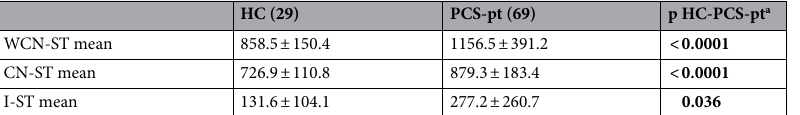
Table 5. Results by Mann Whitney analysis for comparing parameters of Stroop Task (ST) RTs, for conditions (WCN–CN) and derived RTs (I). WCN word color naming, CN color naming, I interference, pt patients. Significant values are in [bold]. a All comparisons remained significant after the Benjamini–Hochberg